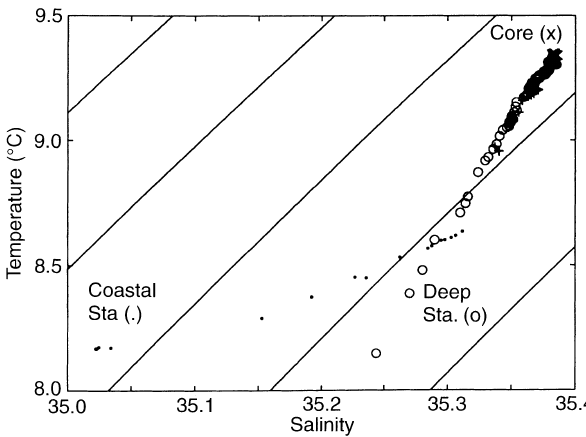
Fig. 4. Potential temperature-salinity plot for data shown in Fig. 3. Data are from (o) 2nd , (x) 5th, (+) 8th and (.) 10th station from the left as marked in Fig. 3 by the open